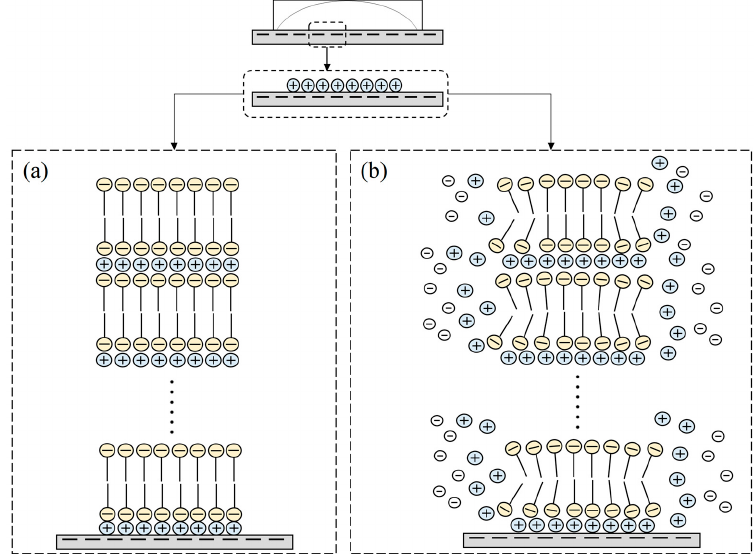
Figure 8. Schematic representation of possible mechanisms for surfactant adsorption on a glass slide: ( a ) SDS; and ( b ) SDS-monovalent ions.